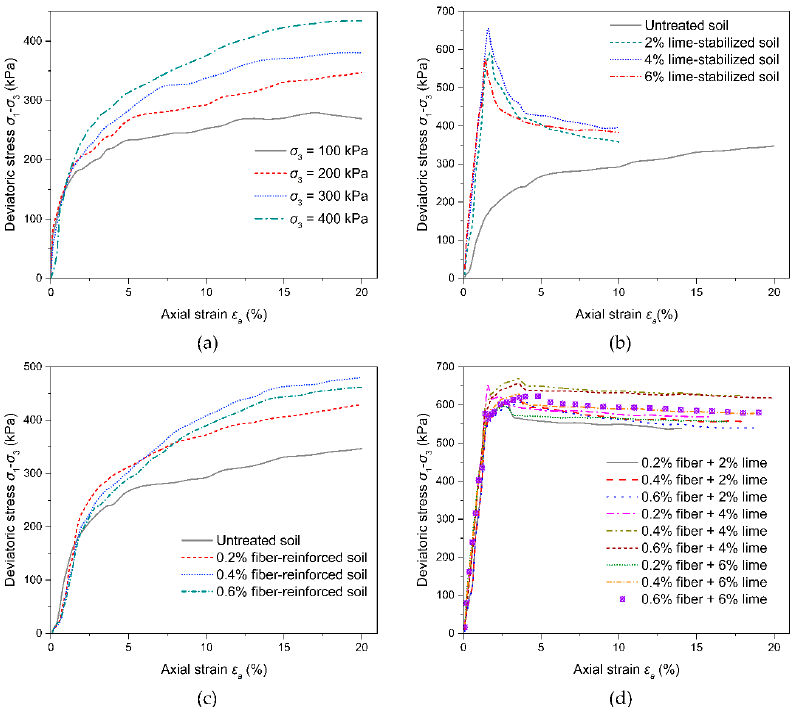
Figure 2. Stress–strain relations for untreated soil tested at various confining pressures and treated soil tested at 200 kPa: ( a ) untreated soil, ( b ) lime-stabilized soil, ( c ) fiber-reinforced soil, and ( d ) fiber-reinforced soil stabilized with lime.